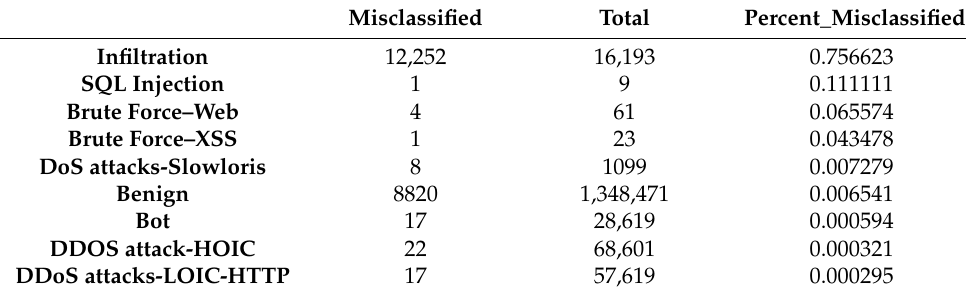
Table 7. Misclassification by attack